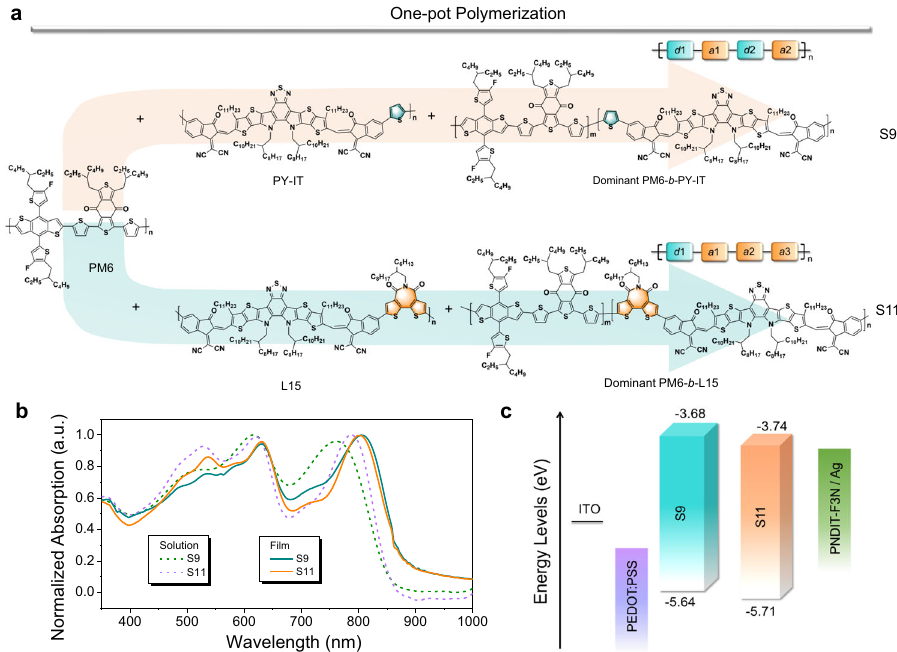
Fig. 1 | Design, synthesis and opto-electrical properties of multicomponent system S9 and S11. a Chemical structures of S9 and S11 synthesized via one-pot polymerization (for details see Supporting Information). b UV-vis absorption